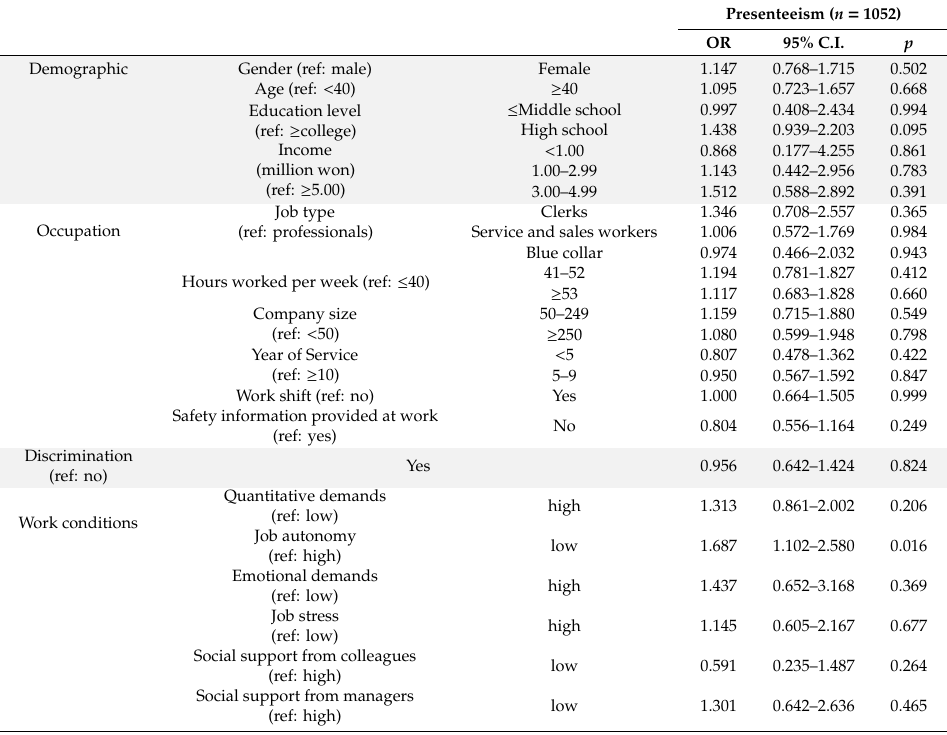
Table 3. Presenteeism among workers exposed to adverse social behavior.